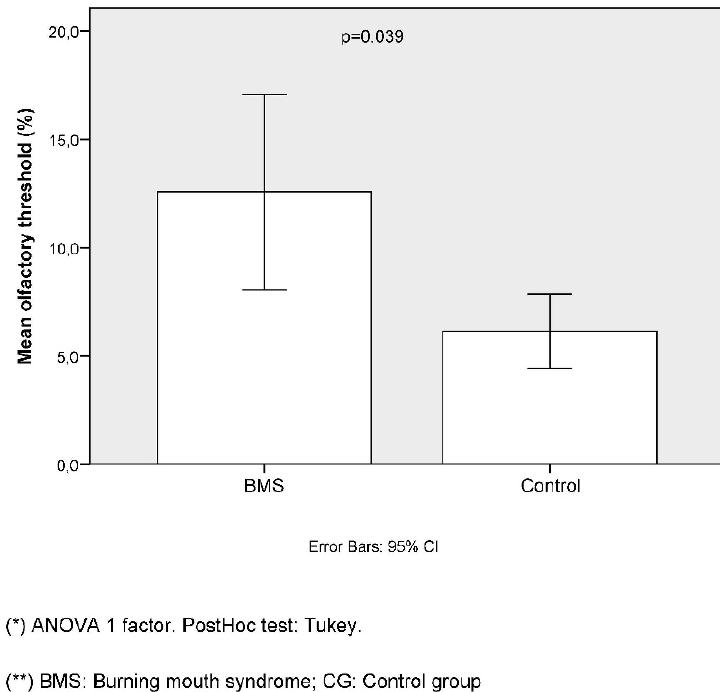
Figure 2 - The BMS patients had higher olfactory thresholds than the controls